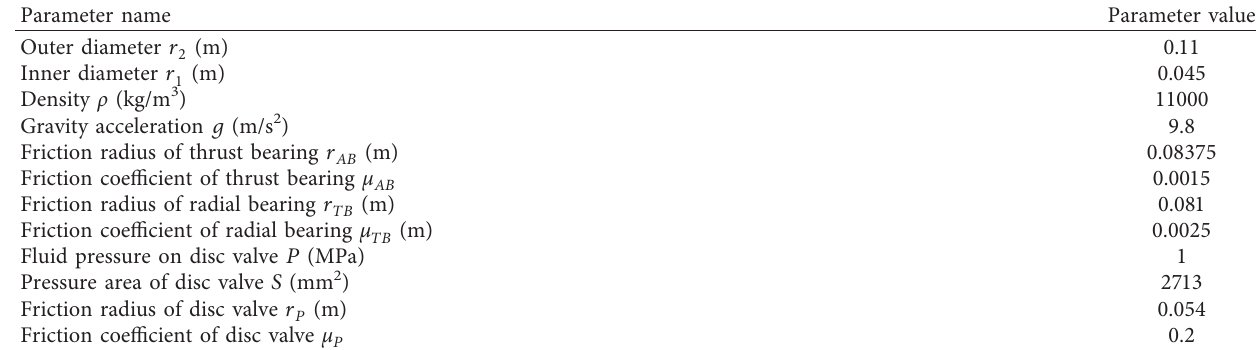
Table 1: The theoretical values of platform design